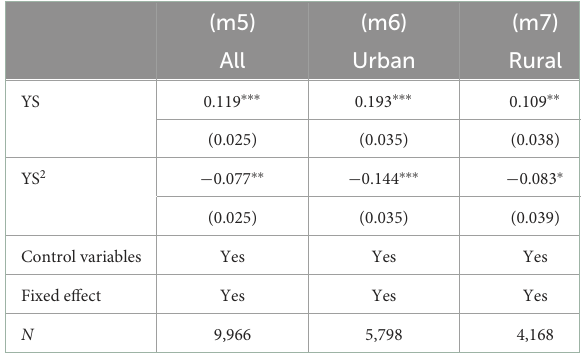
TABLE 4 The inverted U-shaped link between educational levels and